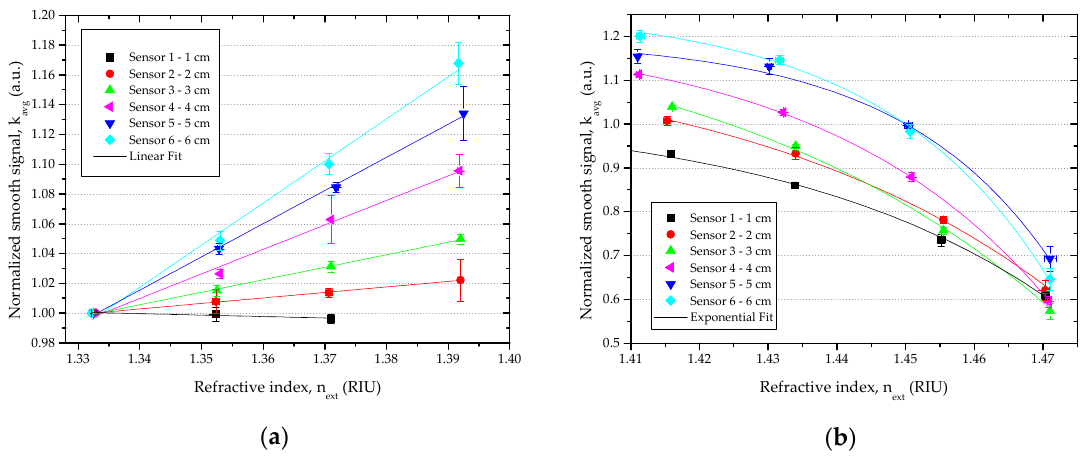
Figure 6. Normalized smooth signal vs. refractive index: ( a ) RI: 1.33–1.39, linear fitting; ( b ) RI: 1.41–1.47, exponential fitting.